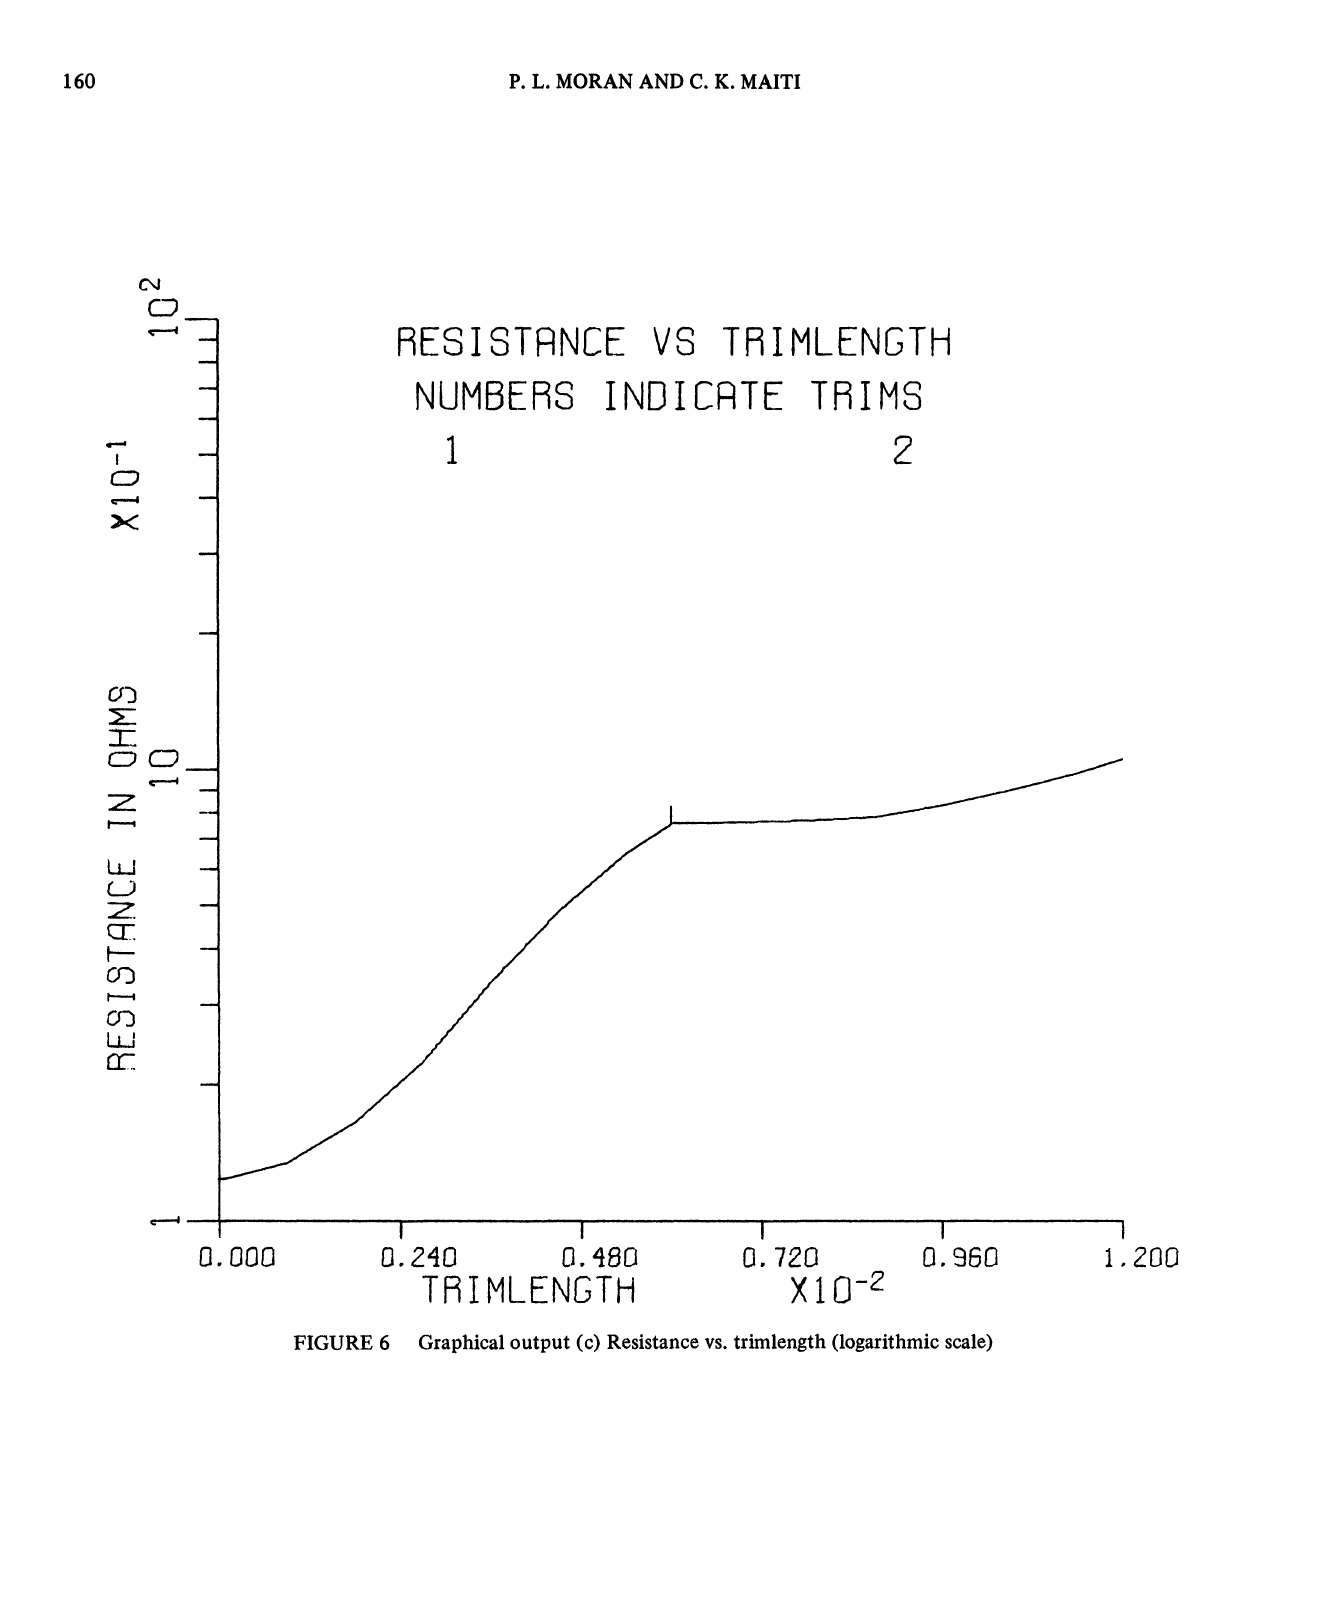
FIGURE 6 Graphical output (c) Resistance vs. trimlength (logarithmic